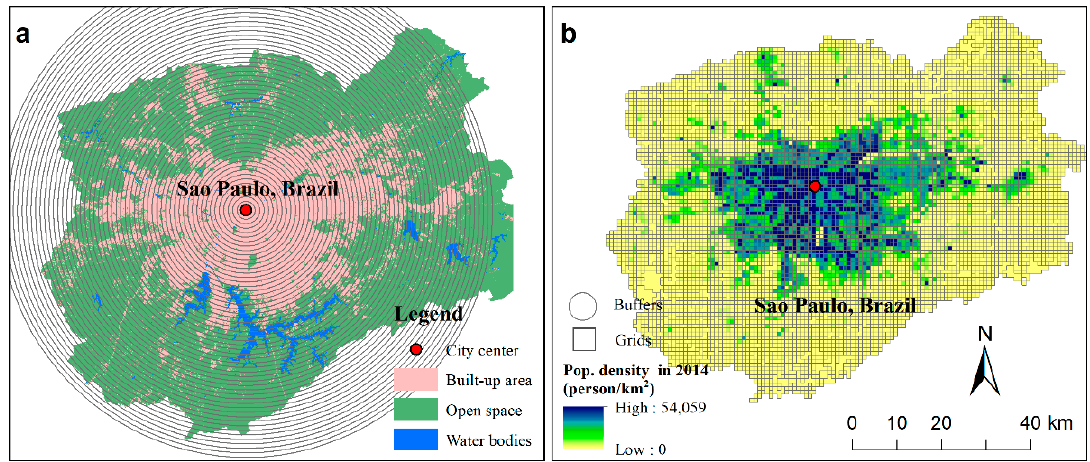
Figure 2. An example of concentric ring analysis ( a ) and grid-based analysis ( b ) in São Paulo, Brazil.